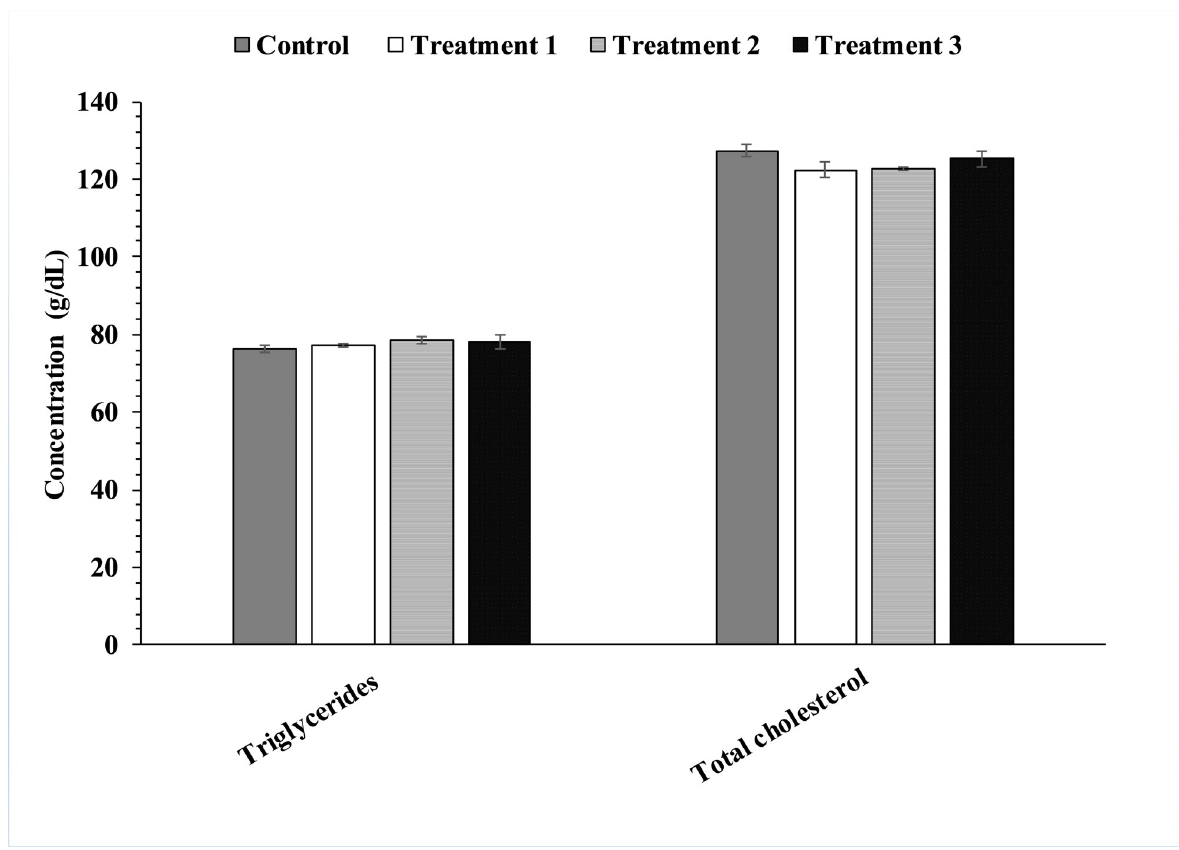
Fig 5. Effects of enzymes treatment on triglycerides and total cholesterol levels. Values represent mean ± (SD).